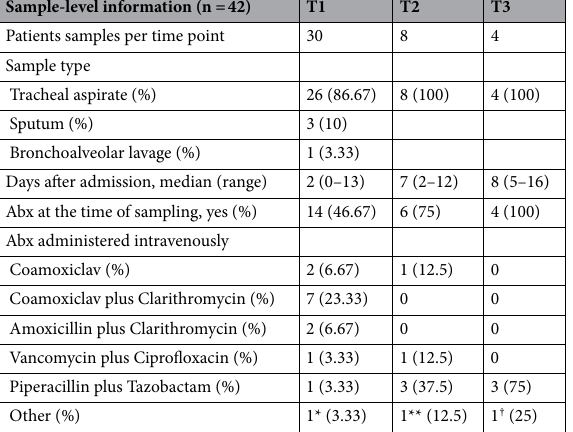
Table 2. Patients samples information. T = time point, Abx = antibiotic. * Doxycyclin. ** Vancomycin. †